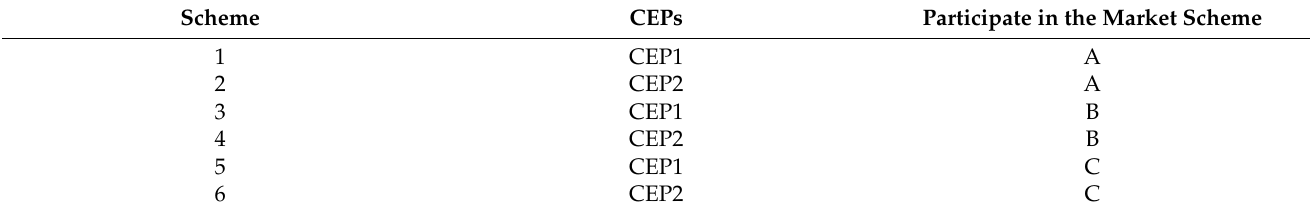
Table 1. CRIES specific scheme.